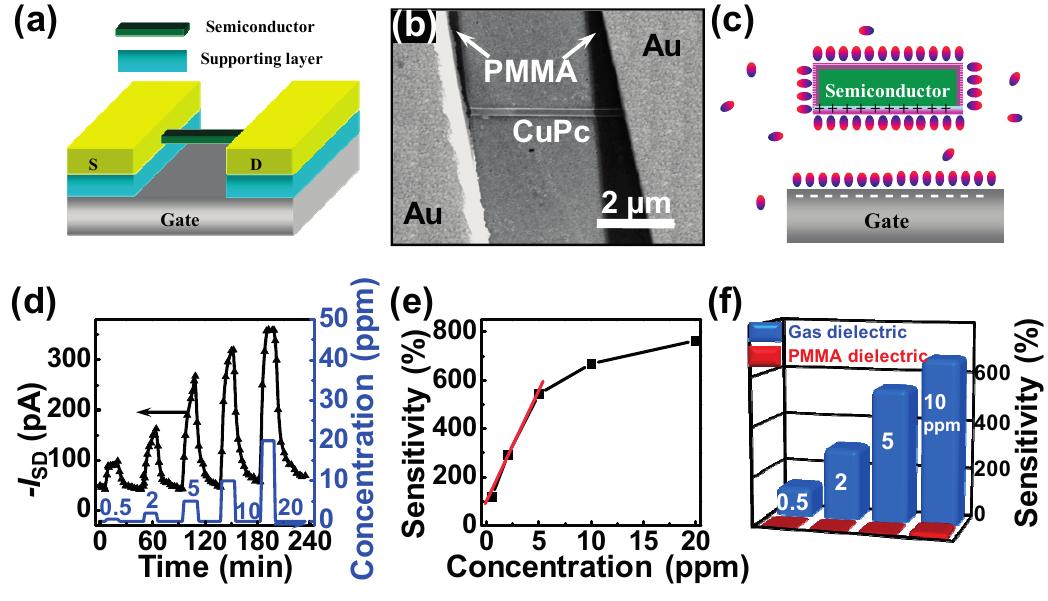
Figure 9. ( a , b ) The schematic and SEM images of gas dielectric FETs based on CuPc nanowire; ( c ) Schematic image for the work principle of gas dielectric sensor; ( d ) Real-time I change of device to various SO concentration (0.5, 2, 5, 10 and 20 ppm) at V = − 10 V SD 2 G = − 15 V at room temperature. The blue line corresponds to SO concentration and V SD 2 (right y-axis); ( e ) Sensitivity of device as a function of SO concentration at V = − 10 V 2 G and V = − 15 V at room temperature. The red line is the linear fitting result in SD ; ( f ) Comparison of the gas sensitivity of gas dielectric (blue) and low-concentration SO 2 PMMA dielectric (red) devices in different SO concentration (0.5, 2, 5 and 10 ppm) 2